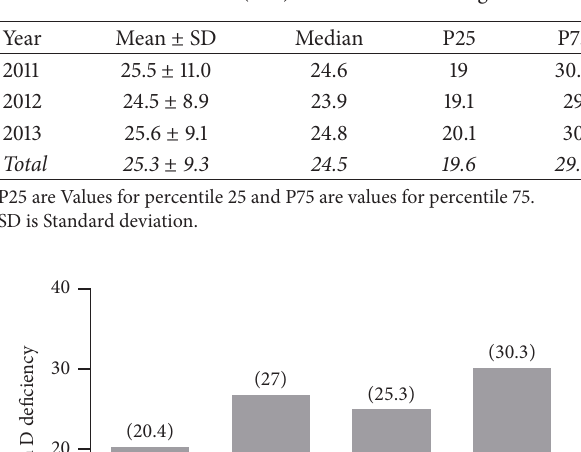
Table 1: Results for serum 25(OH)D levels observed by analysis of a clinical laboratory databank. Data are presented as mean ± standard deviation and median of 25(OH)D concentration in ng/mL.